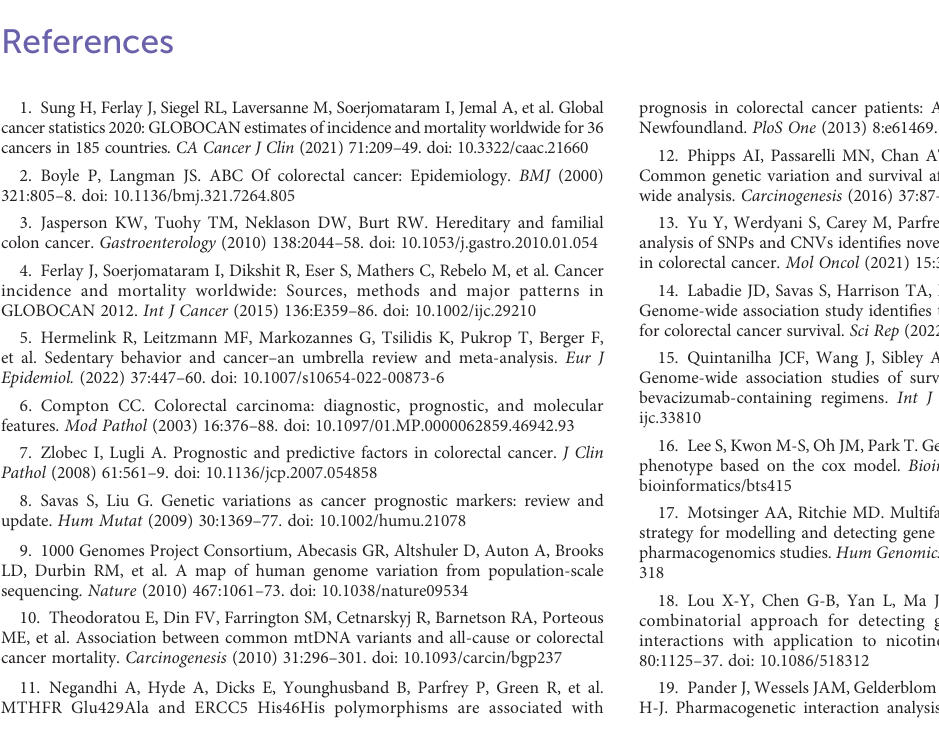
SUPPLEMENTARY TABLE 5 Information on the genes. SUPPLEMENTARY FIGURE 1 Kaplan Meier curves for select 2-way and 3-way